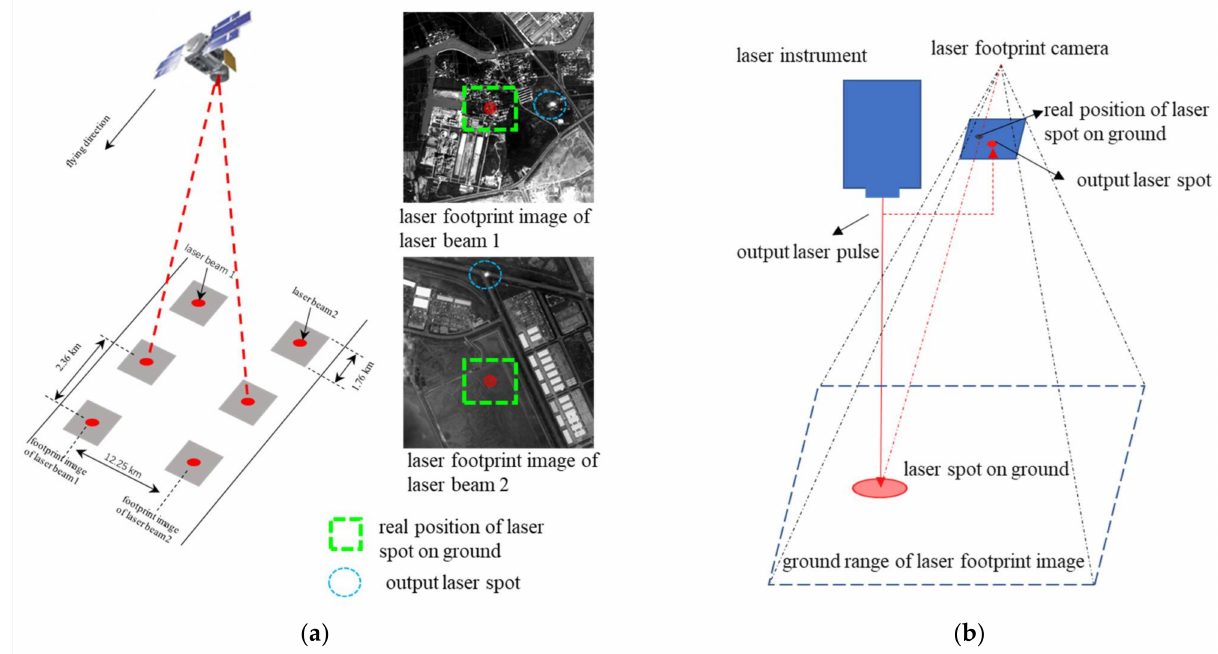
Figure 1. Laser altimetry system of the GF-7 satellite. ( a ) Working scheme and data distribution of the GF-7 satellite laser altimetry system; ( b ) simplified geometry relationship of laser altimeter and laser footprint